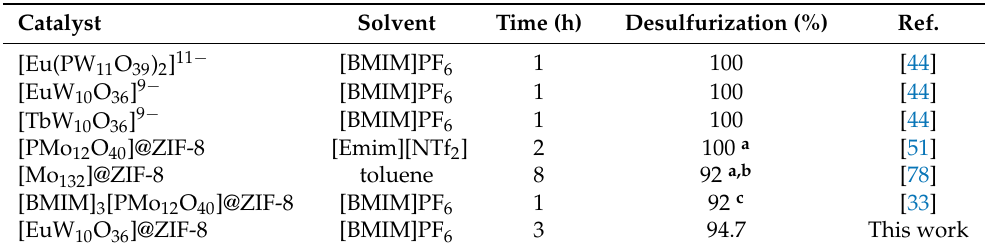
Table 1. Extractive/oxidative desulfurization efficiency of model diesel, using H 2 O 2 as oxidant and various POM-based